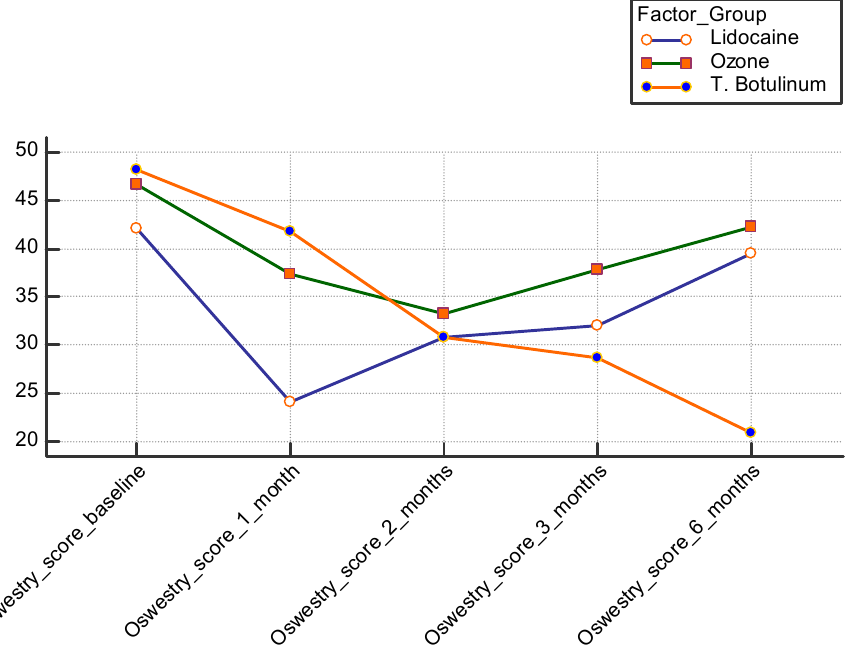
Figure 3. Post-injection comparison between the three studied groups as regards ODI score. ODI: Oswestry Disability Index.